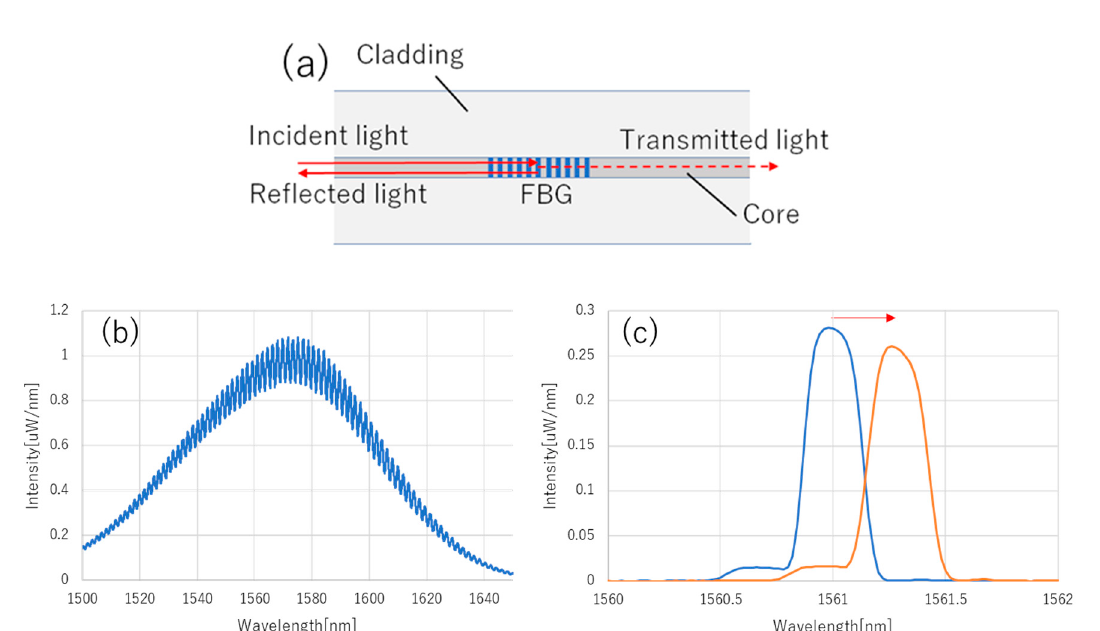
Figure 1. ( a ) The schematic diagram of the FBG sensor. The incident light propagates through the optical fiber core, which is surrounded by cladding. FBGs have a periodic refractive index change inscribed on the optical fiber core. An example of the incident light ( b ), and the real reflected spectrum of FBG and its change against tension ( c ) are shown in the graph. These spectrums are obtained with the optical spectrum analyzer (OSA) (AQ6370D, Yokogawa Electric Co., Tokyo, Japan) with a resolution setting of 0.1 nm.